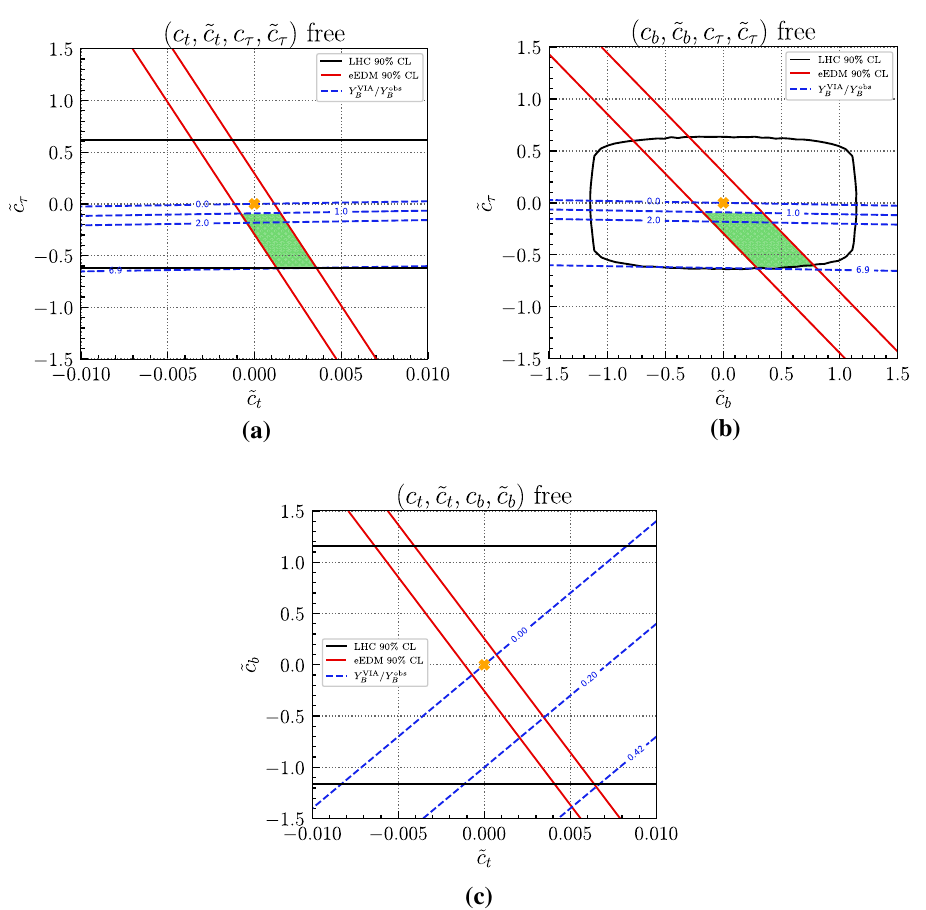
/ Y obs (blue). For B B